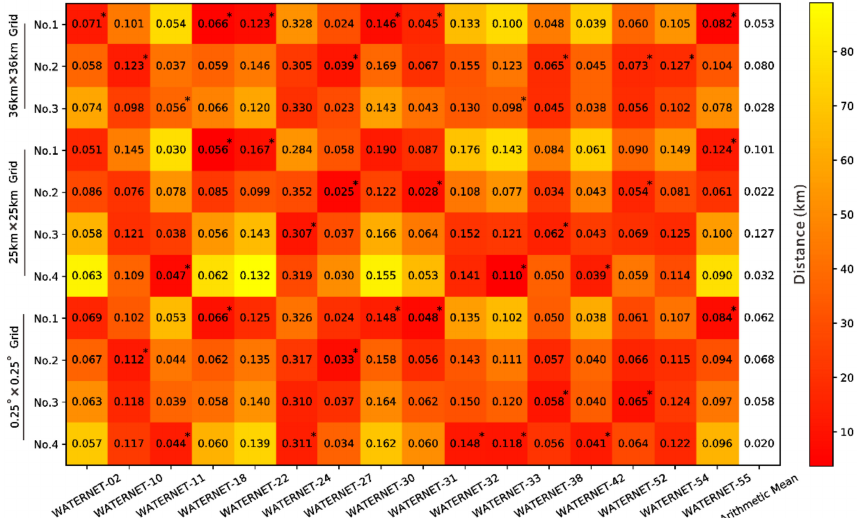
Figure 13. Root-mean-square errors (RMSEs) between in situ measurements and the upscaled SM at multiple pixel scales. The gradient color represents spatial distances between the ground-based sites and the center points of pixels. The asterisk means that the site locates within the pixel zone. The arithmetic mean values are obtained by averaging the ground-based observations derived from multiple sites within the same pixel area. The RMSEs between arithmetic mean values and their corresponding upscaled SM at different pixel scales are shown in the extreme righthand